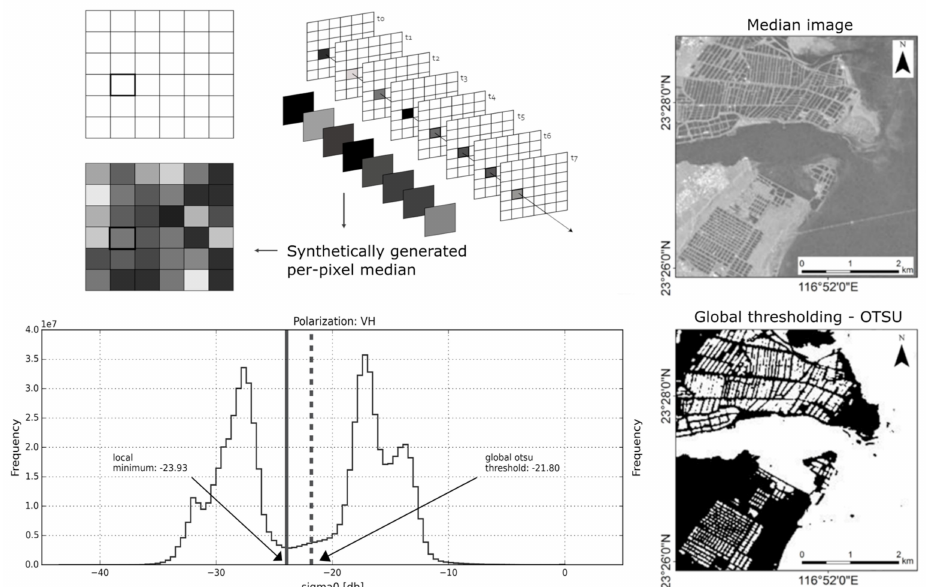
Figure 7. Histogram-based thresholding (OTSU) on the temporally smoothed SAR time series (median